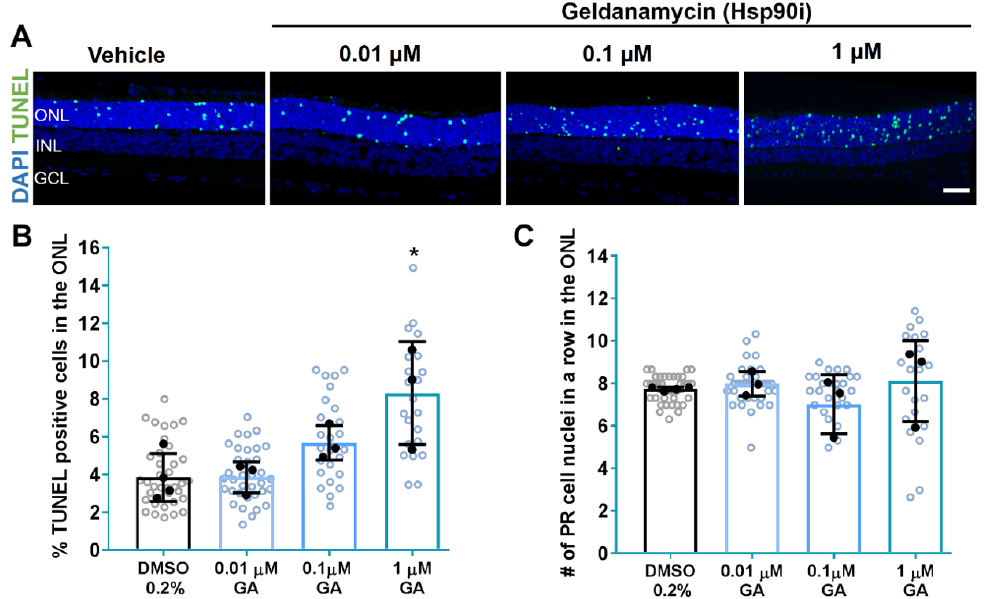
Figure 2. Inhibition of Hsp90 does not improve photoreceptor cell survival in RHO P23H retinae in vitro. Retinae from RHO P23H transgenic rats were explanted at postnatal day 9 (PN9), cultivated for 6 days in vitro (DIV6), and treated every second day with different concentrations of the Hsp90 inhibitor geldanamycin (GA). DMSO at a concentration of 0.2% was used as vehicle control. ( A ) Explants were stained with TUNEL assay to differentiate photoreceptors undergoing cell death (green) using nuclei counterstaining with DAPI (blue). ( B ) Bar chart shows the percentage of TUNEL-positive cells in the ONL. A significant increase in the percentage of dying cells was observed after treatment with 1µM GA compared to the respective control. ( C ) Comparison of the number of remaining photoreceptor cell nuclei in a row in the ONL. Retinae treated with Hsp90 inhibitor did not show any significant change in the number of photoreceptor cell rows. Scale bar is 50 µm. The values were quantified by scoring several images (open circles) from DMSO-treated retinae (closed circles, n = 4) and GA-treated retinae at 3 different concentrations (0.01, 0.1, and 1 µM, closed circles, n = 3, for each). The data are presented as mean ± SD, and one-way ANOVA analysis was performed. * p < 0.05. Hsp90i: Hsp90 inhibitor; ONL: outer nuclear layer; INL: inner nuclear layer; GCL: ganglion cell layer; GA: geldanamycin; DIV: days in vitro; PR: photo- receptor.